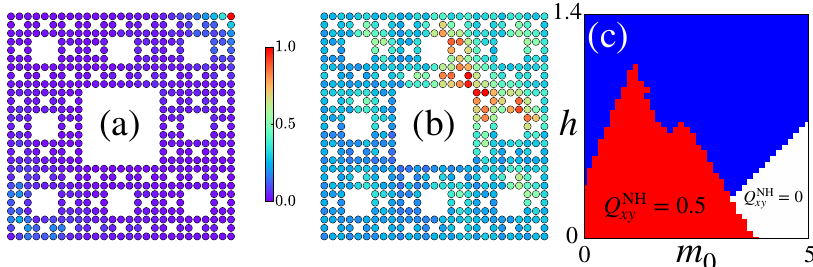
Fig. 4 Non-Hermitian (NH) second-order skin effect and associated phase diagram on Sierpinski carpet fractal. a Total weight of all the left eigenvectors (normalized by its maximum value) of H SO [Eq. (4)] for m 0 = 1.5, g = 0.5 and h = (0.35, 0.35, 0) with open boundary conditions in all directions, showing second-order skin effect at an outer corner. b Same as a , however with periodic boundary condition in both x and y directions, displaying a second-order inner skin effect around inner corners. c Global phase diagram of H SO on the ( m 0 , h ) plane with the same boundary condition as ¼ 0 : 5 (red region), (ii) a NH trivial insulator with Q NH ¼ 0 : 0 in b and g = 0.5, featuring (i) a NH quadrupole insulator with NH quadrupole moment Q NH xy xy (white region), and (iii) a NH insulator where Q NH is not well de fi ned (blue region). Throughout we set t = t 0 = 1, R = 2 a and r 0 = a . The right eigenvectors xy of H SO display second-order (inner) skin effect around the diagonally opposite corners, as shown in Supplementary Fig.